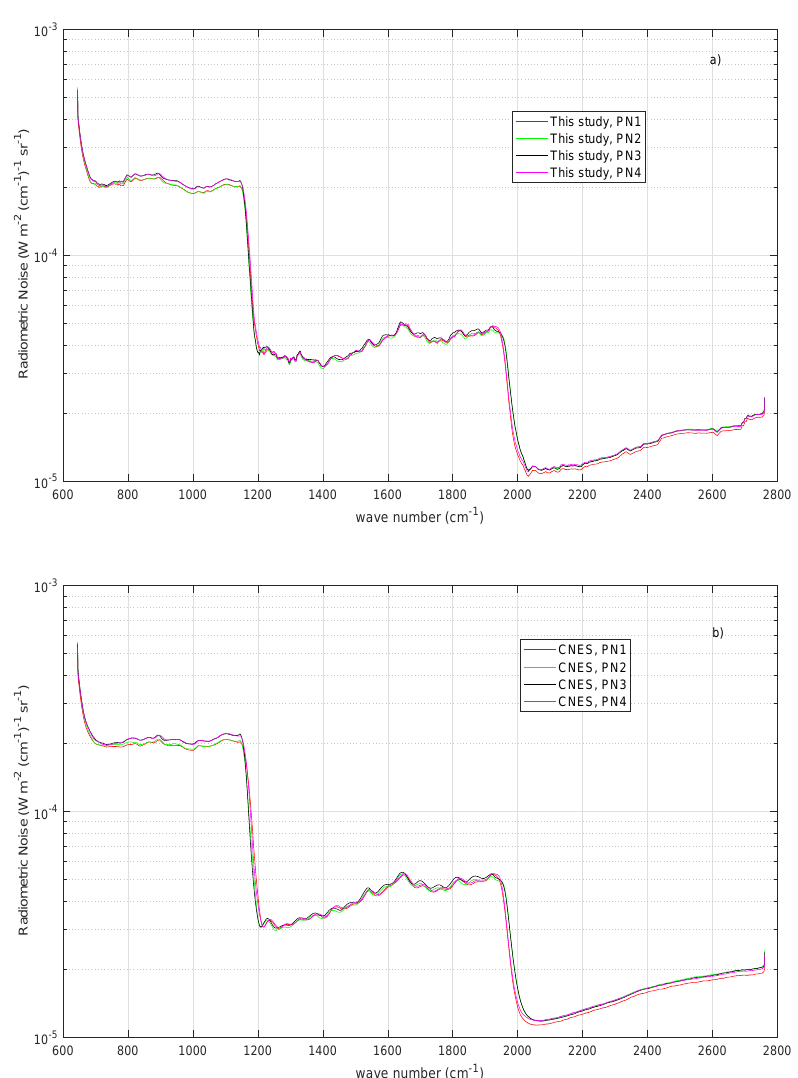
Figure 7. ( a ) Results for the radiometric noise for the IASI-C instrument as a function of the IASI pixel or IFOV; and ( b ) same as ( a ), but now for comparison the CNES release of the nominal radiometric noise is